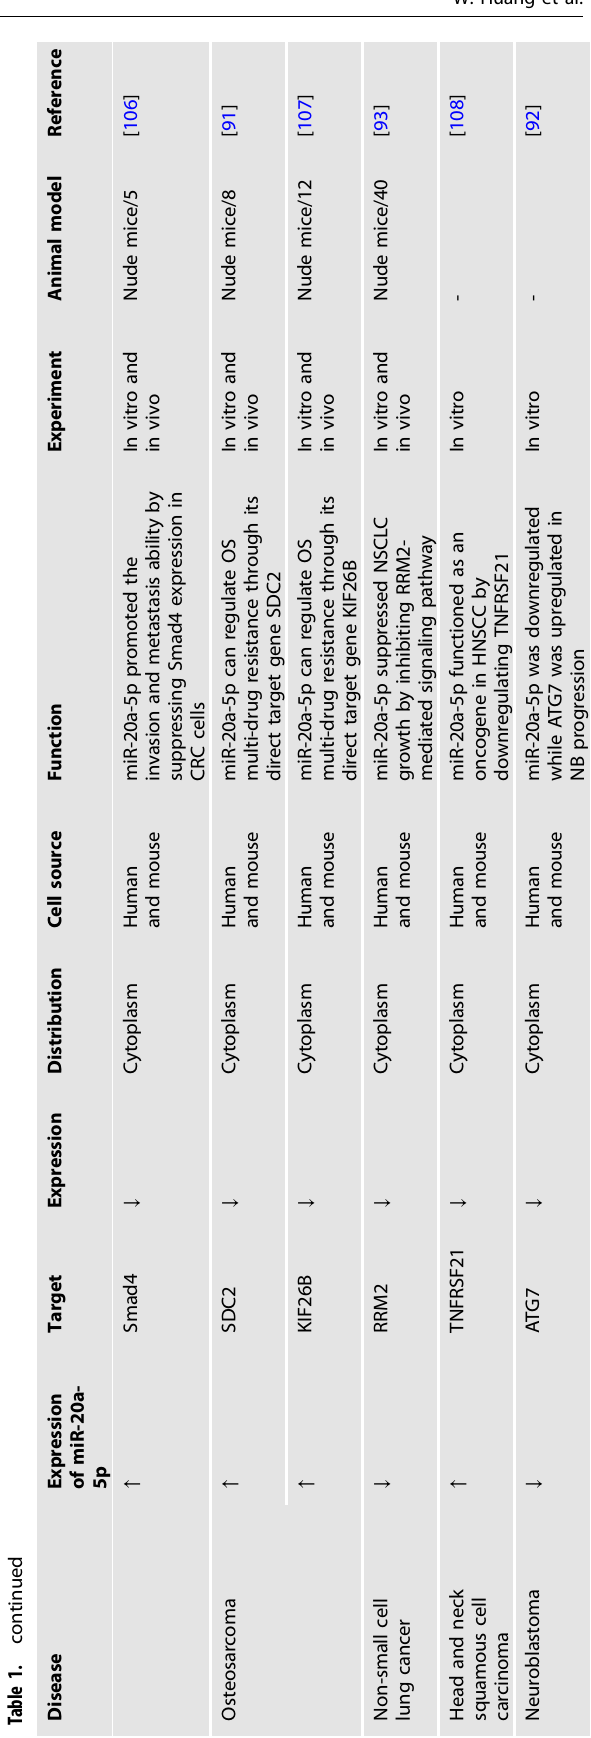
downstream mRNA to regulate the processes of cancers. Research on circRNA-miRNA network continues to advance. With the deepening of scholars ’ understanding of circRNA-miRNA networks, we fi nd that circRNA-targeted regulation is a new pathway for cancer treatment, providing new possibilities for the research and development of related drugs. CONCLUSIONS Recently, massive studies have revealed the mechanism of miRNAs in cancer in great detail. The overexpression or T a